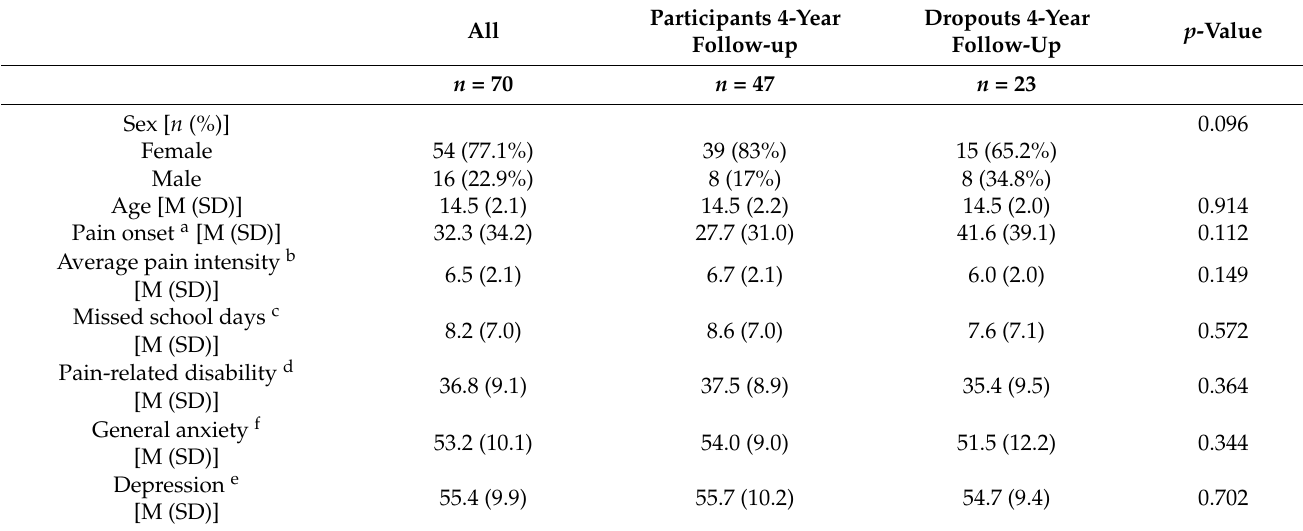
Table 1. Socio-demographic and pain characteristics at study inclusion.